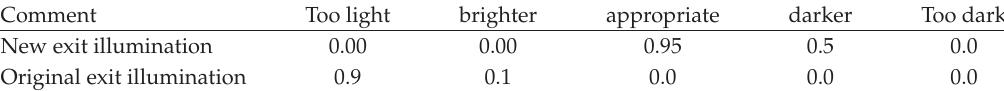
Table 6: Assessment results of lighting easing in exit